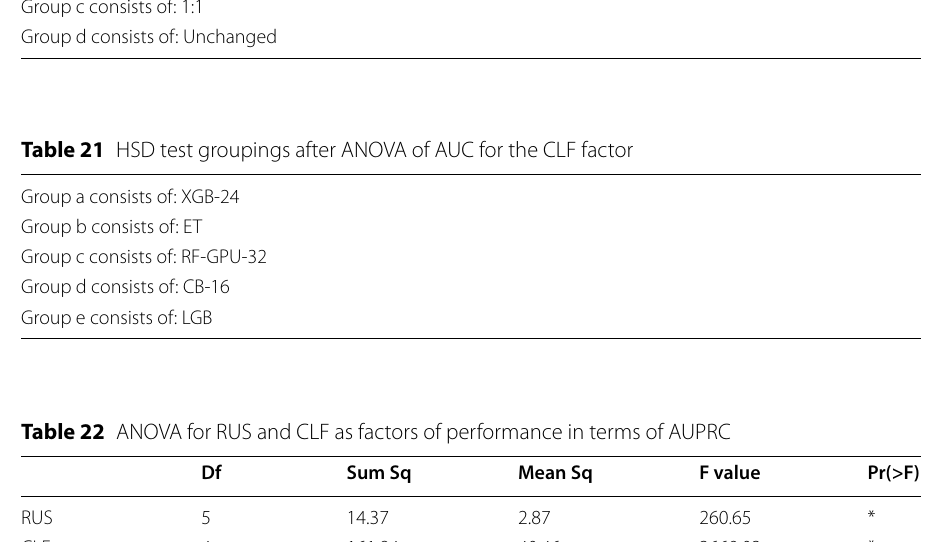
Table 22 ANOVA for RUS and CLF as factors of performance in terms of AUPRC Df Sum Sq